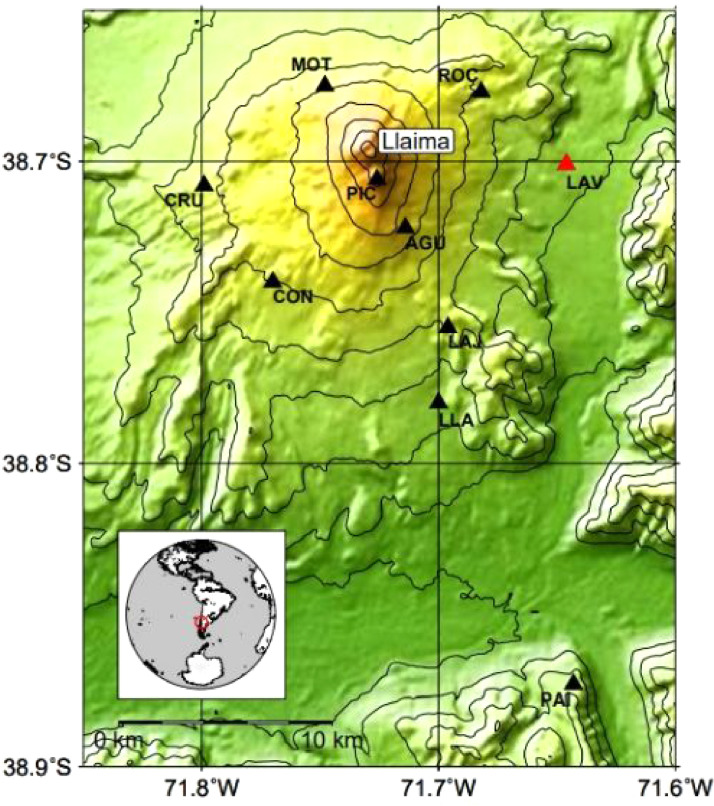
Llaima volcano and its seismic stations [3].